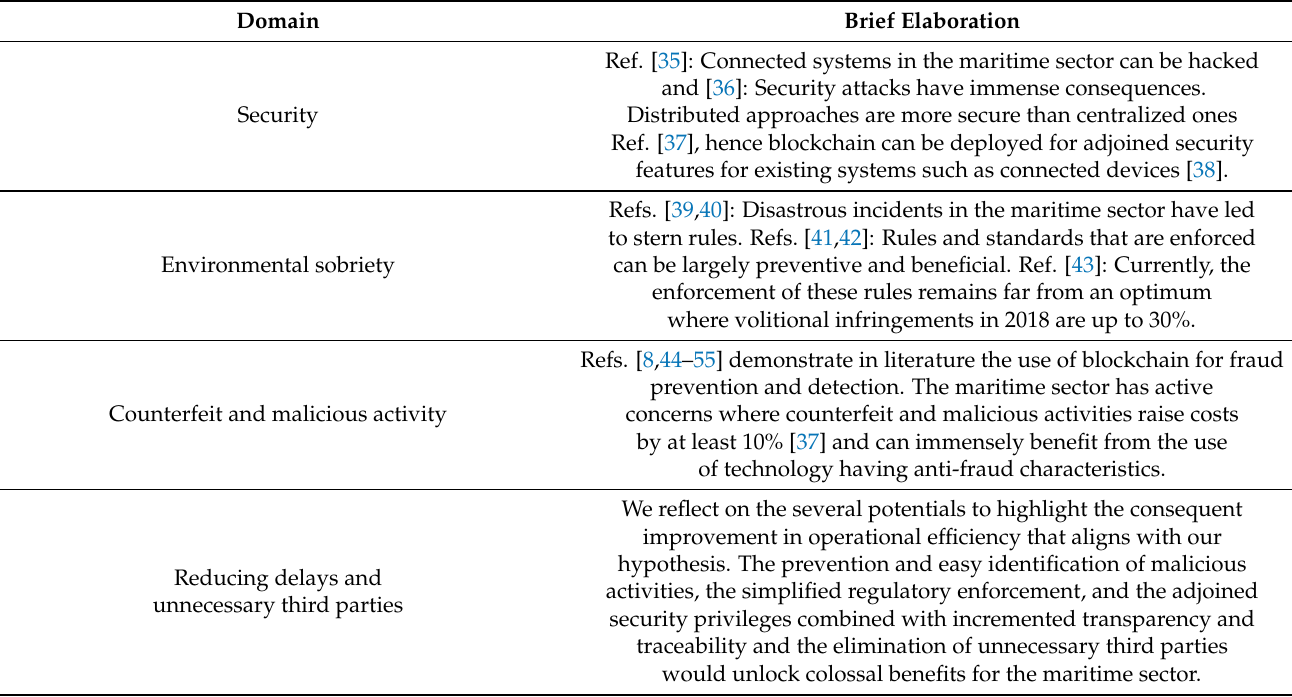
Table 2. Extending blockchain’s spectrum of domain